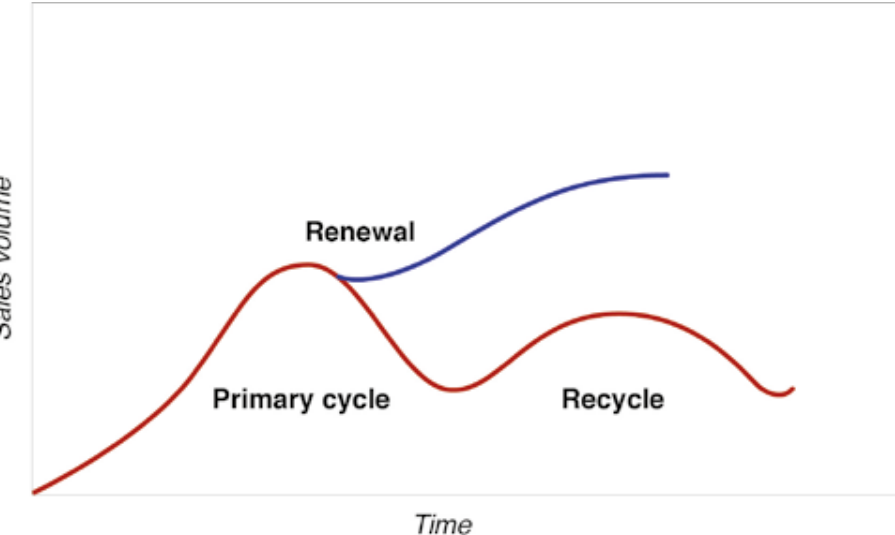
Figure 2. Life cycle of an agri-food